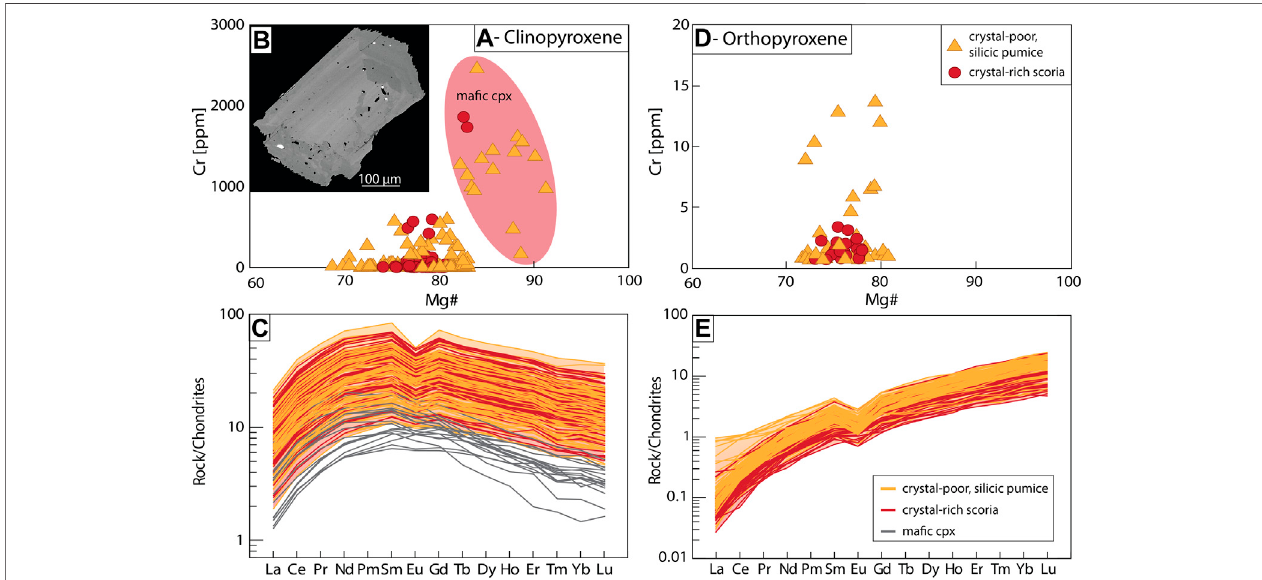
FIGURE 4 | Compositional variations of clino- (A) – (C) and orthopyroxene (D) , (E) from crystal-poor, silicic pumice and crystal-rich scoria. (A) Binary plots of Cr vs. Mg# [Mg# (cid:2) Mg/(Fe + Mg) × 100)] indicate the presence of ma fi c clinopyroxene with high Mg# and high Cr in both, early-erupted pumices and late-erupted scoria. (D) OrthopyroxeneshowsalesspronouncedspreadofCratdistinctlylowerconcentrationsthanclinopyroxeneimplyingcrystallizationfromslightlymoreevolvedmelts.REE patterns of clinopyroxene (C) do not distinguish silicic pumices from scoria but give lower REE contents for ma fi c scoria. Orthopyroxene REE patterns (E) plot in a narrower compositional range than clinopyroxene suggesting crystallization from compositionally less variable melts. Measurement errors are smaller than the